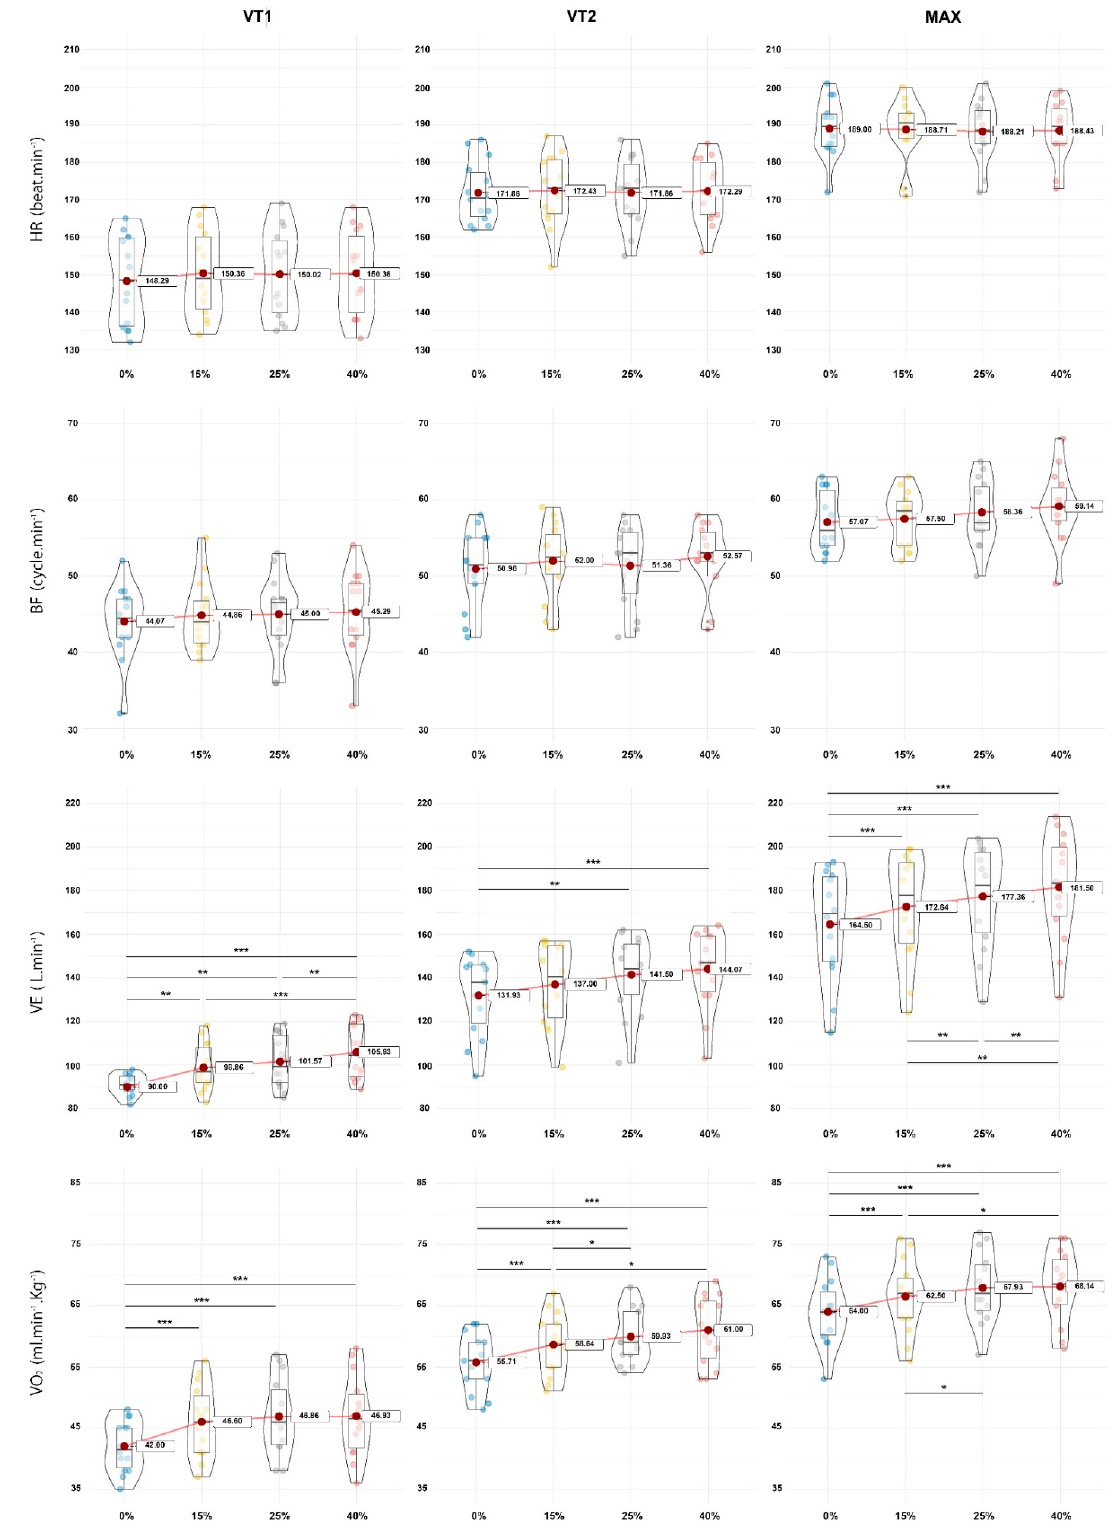
Figure 2. Violin plot of dependent variables, heart rate (HR), breathing frequency (BF), ventilation ( VE ), oxygen consumption ( VO 2 ) for all time points (VT1, VT2 and MAX) for slope conditions (0, 15, 25 and 40%). Statistical differences observed were noted as follow; * p < 0.05, ** p < 0.01 and *** p <